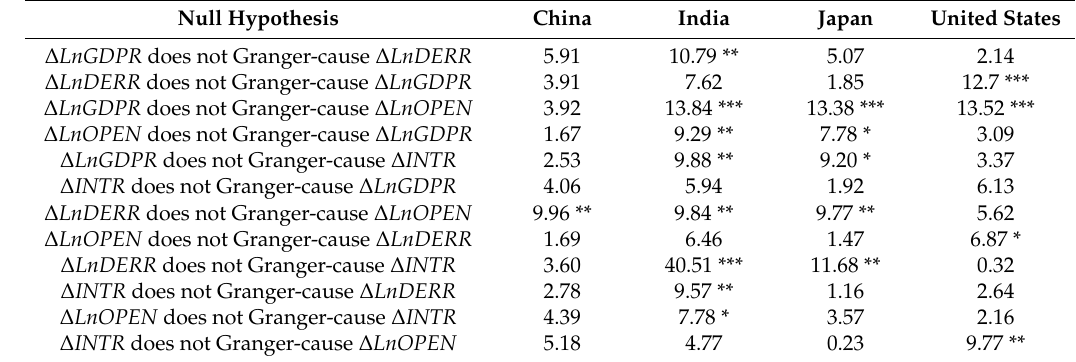
Table 7. Causality tests (the model includes GDP growth). Null Hypothesis China